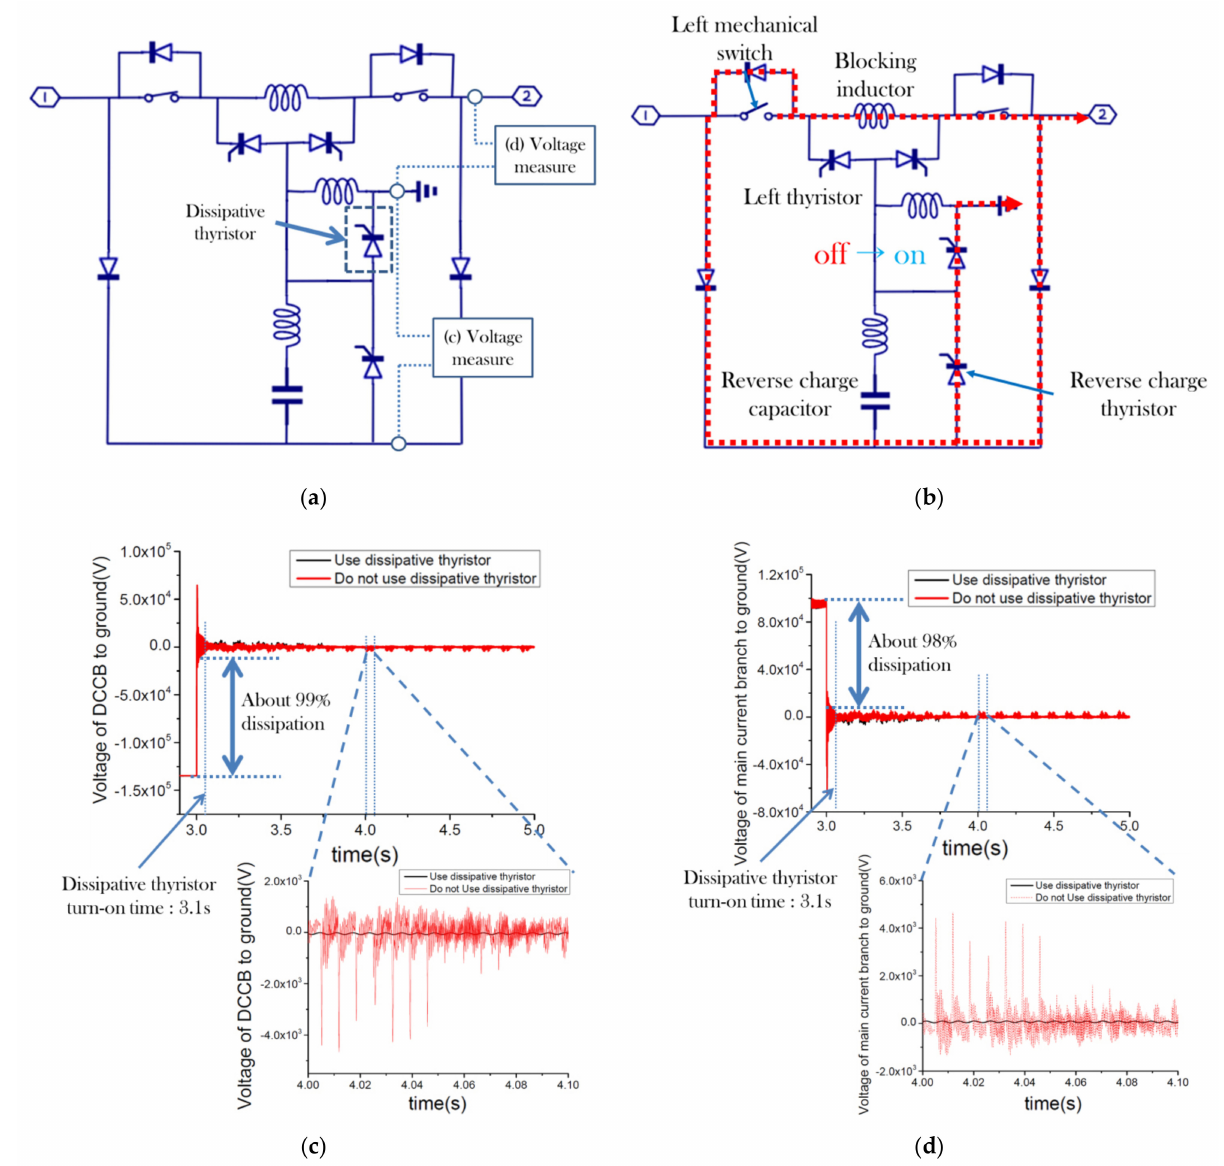
Figure 9. Simulation of energy dissipation in the DCCB proposed in this paper ( a ) Schematic illustration of the DCCB diagram in the presence of the dissipative thyristor. ( b ) Current flow in the presence of the dissipative thyristor. ( c ) Graph of voltage between the DCCB and ground over time. ( d ) Graph of voltage between the main current branch and ground over